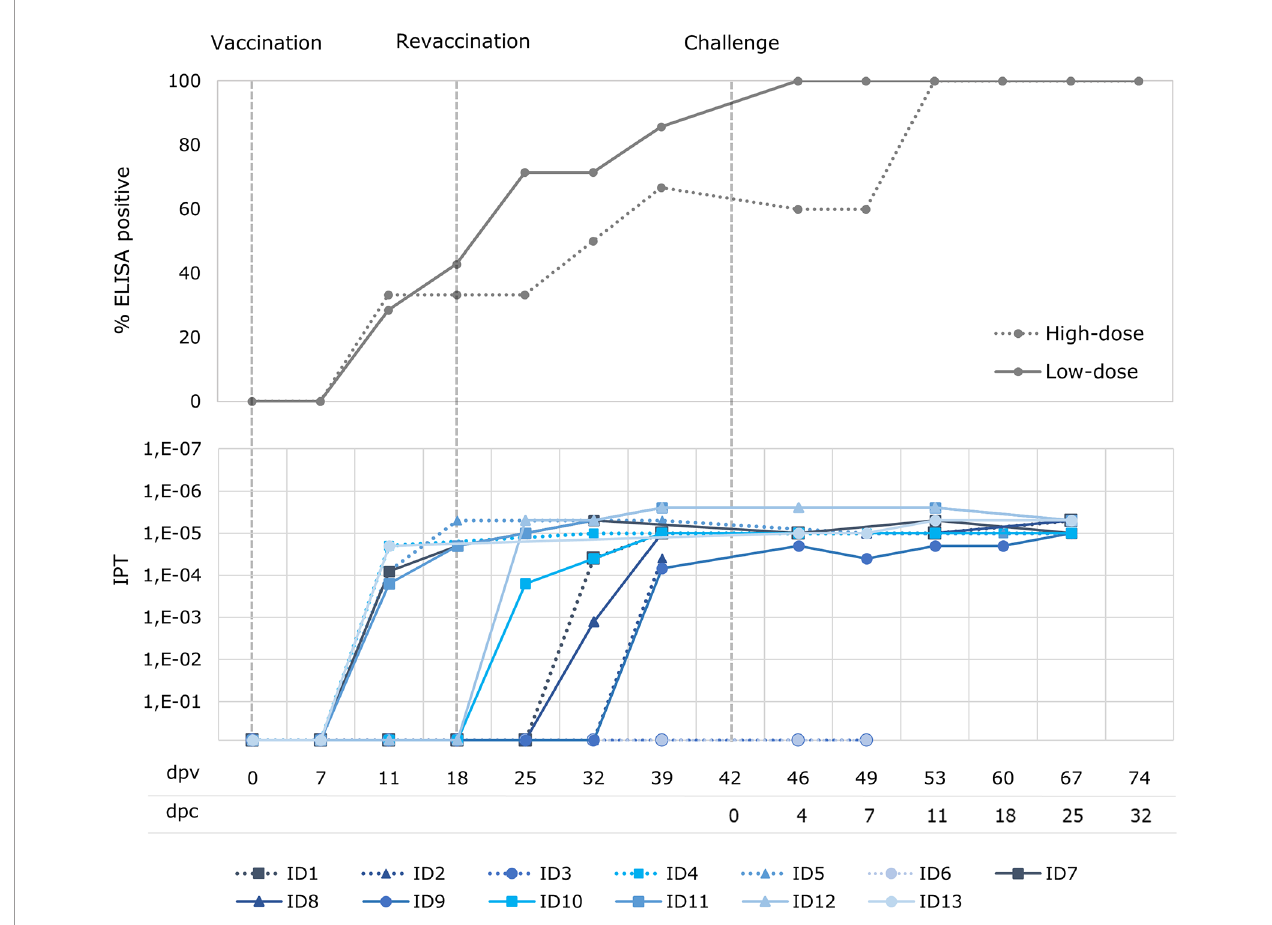
FIGURE 3 | Percentage of wild boar with positive antibody response (ELISA) and titers of antibodies (indirect immunoperoxidase test; IPT) after oral vaccination with 10 3 TCID 50 (low-dose group; unbroken lines) and 10 4 TCID 50 of Lv17/WB/Rie1 ASFV (high-dose group; dotted lines) after vaccination (dpv) and challenge